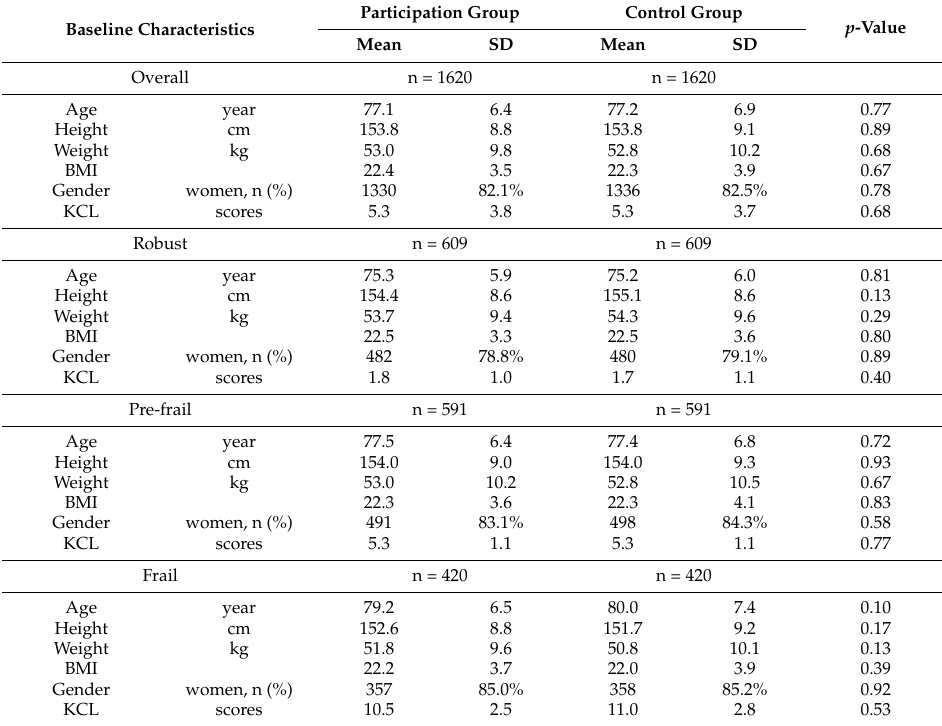
Table 1. Baseline characteristics of the study participants in the two groups. Baseline Characteristics